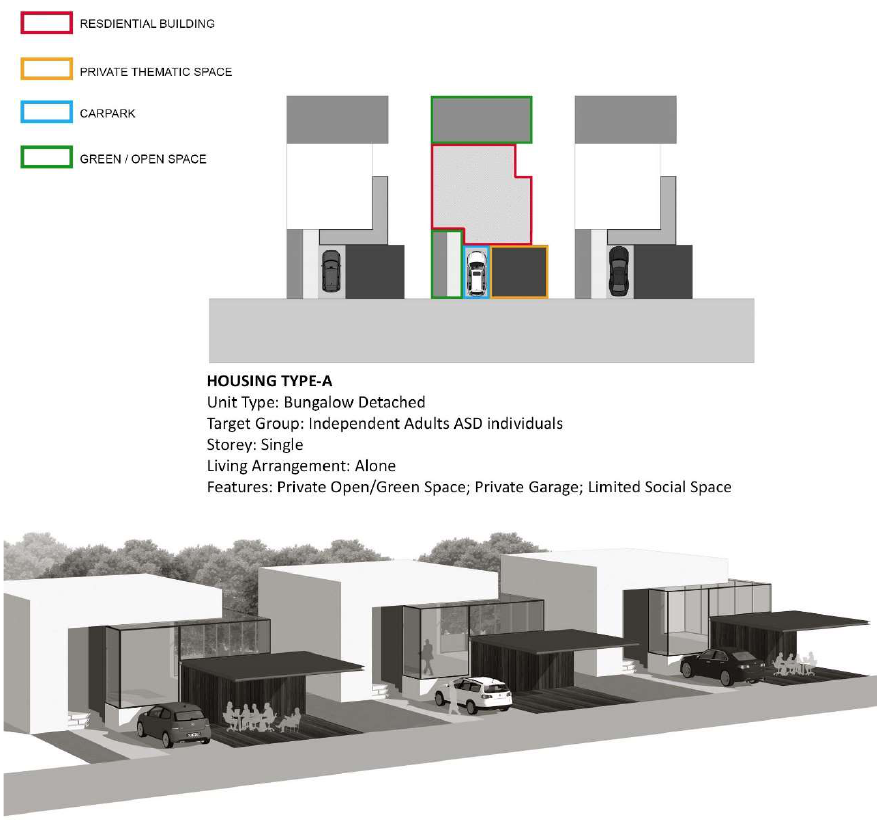
Figure 3. Proposed bungalow (detached) with private interesting space.